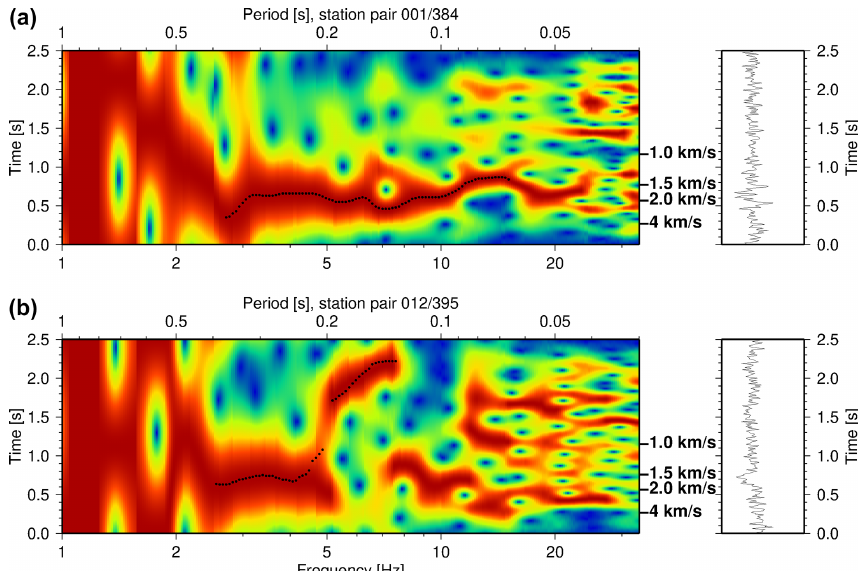
Figure 5. Example of dispersion curve analysis for two traces (left panels) of the cross correlation of the vertical component seismic records (right panels) between station 001 and 384 (a) and station 012 and 395 (b) . The dispersion curve analysis is in the left panel (red colours indicate high amplitudes, blue colours indicate low amplitudes). Traces are normalized in every frequency/period band, travel time picks (i.e. the dispersion curve) are indicated by black dots. Corresponding group velocities are indicated at the right side of the panel. A dispersed surface wave curve (Rayleigh phase) can be identified for signal periods between 3 and 15Hz (a) and ∼ 2.5 and 7Hz (b) . Station pair 012/395 crosses a region of low shear wave